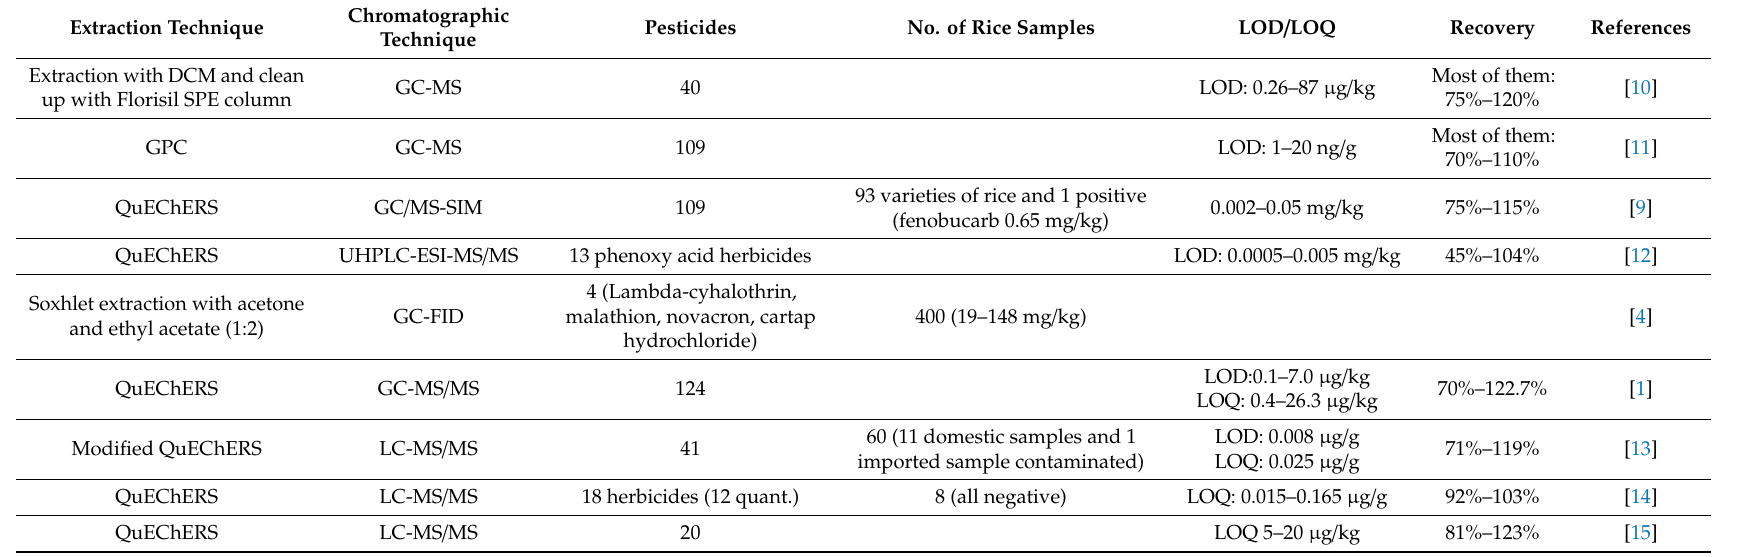
Table 1. Compilation of methods to determine pesticides in rice